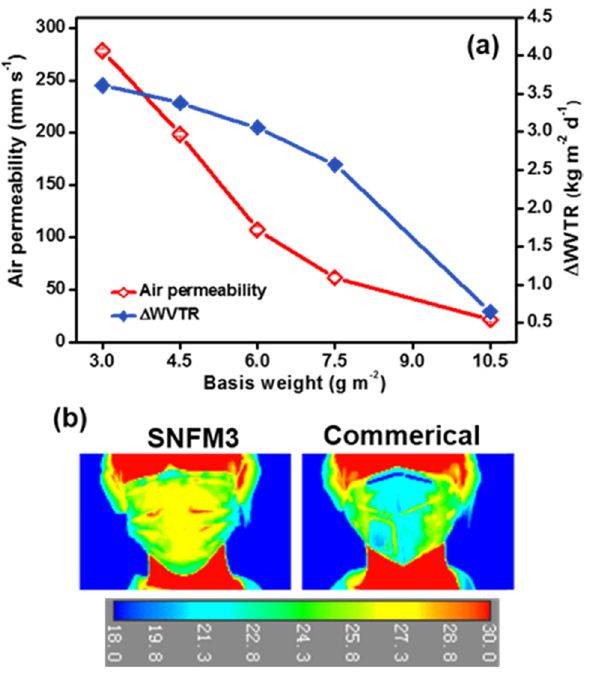
Figure 6: Air permeability and Δ WVTR of SNFMs with various basis weights ( a ) and thermal images of faces covered with SNFM3 ( left ) and the commercial face mask ( right ) ( b )